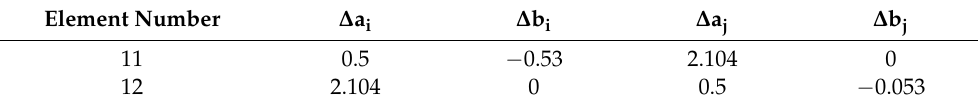
Table 3. Rigid arm position parameters.